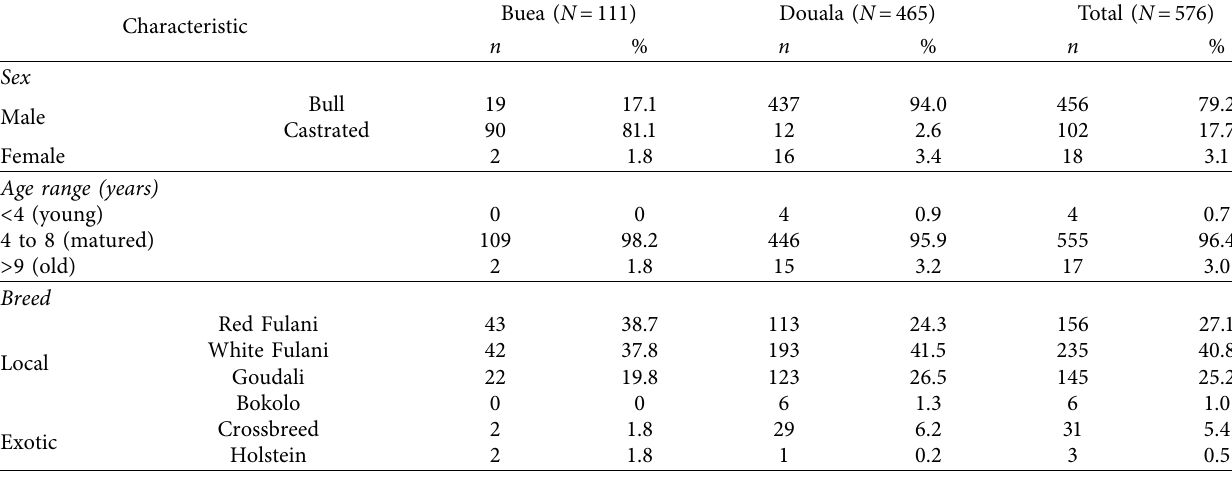
Table 2: Cattle demographic characteristics.